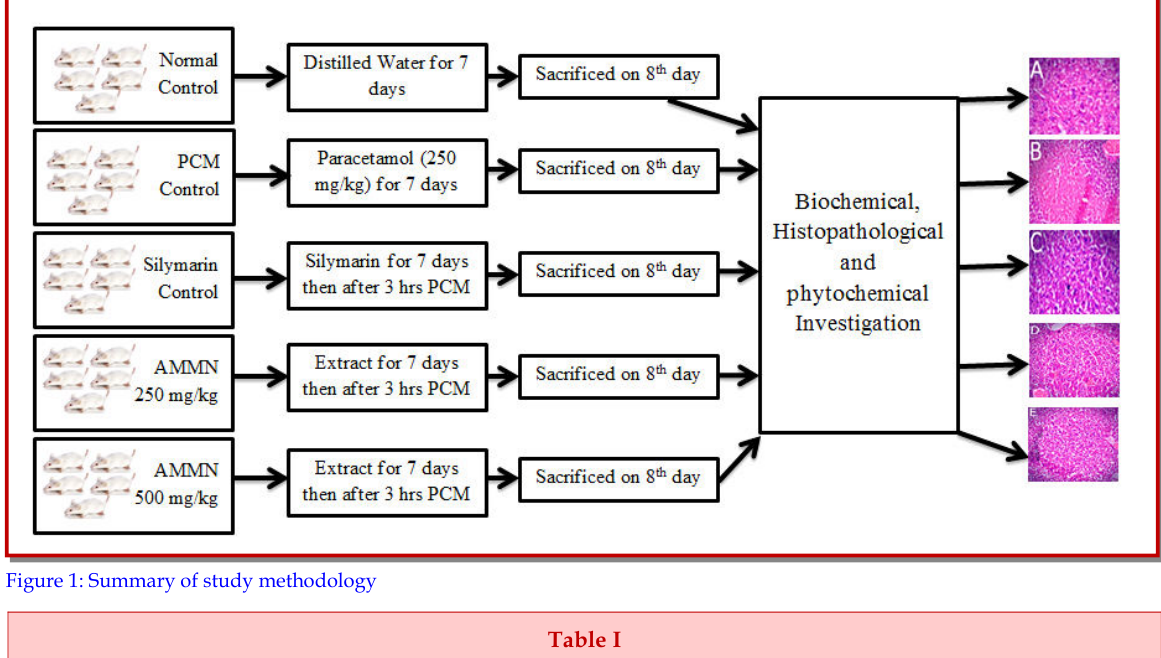
Protocols for phytochemical screening of Morus nigra